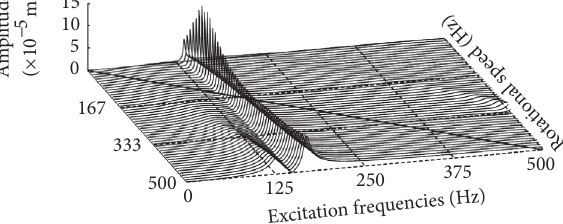
Figure 15: Spectral map of the developed rotor-bearing